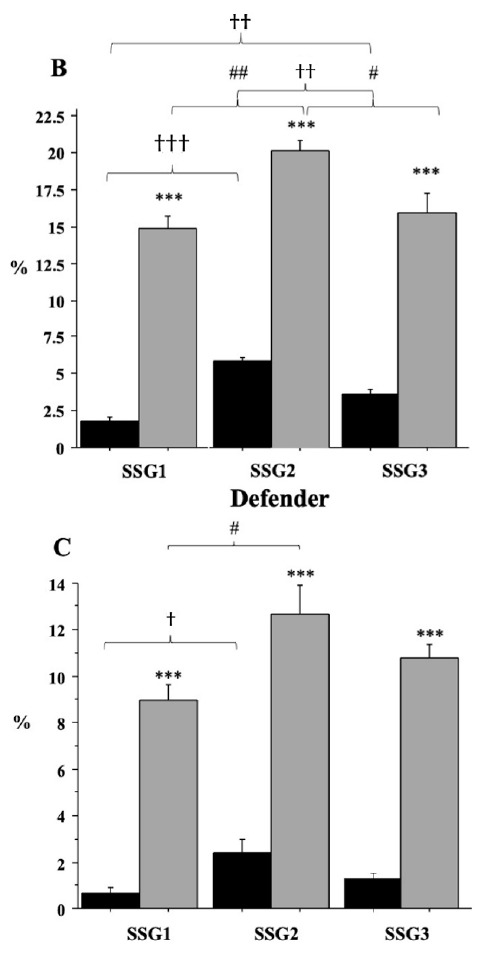
Figure 1. Percentage of total time spent at high speed (% hst; v > 16 km/h) and at high metabolic power (% hmpt; MP > 20 W) recorded in SSG1, SSG2 and SSG3 for attacker ( A ), midfielder ( B ) and defender ( C ). Values are expressed as mean ± SD. * Significant difference between % hst and % hmpt in the same SSG (*** p < 0,001); † Significant difference between % hst in different SSGs († p < 0.05; †† p < 0.01; ††† p < 0,001); # Significant difference between % hmpt in different SSGs (# p < 0.05; ## p < 0.01; ### p < 0,001).